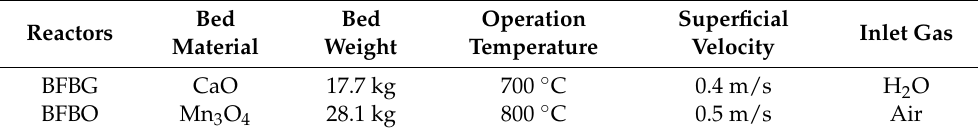
Table 6. The initial and boundary operating parameters of the